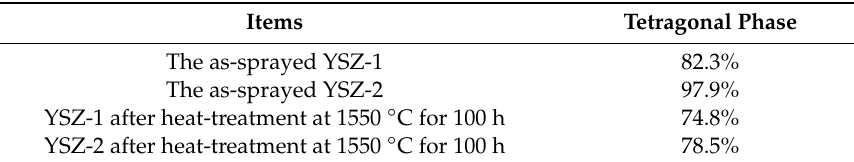
Table 2. Phase content of YSZ coatings prepared by PS–PVD.